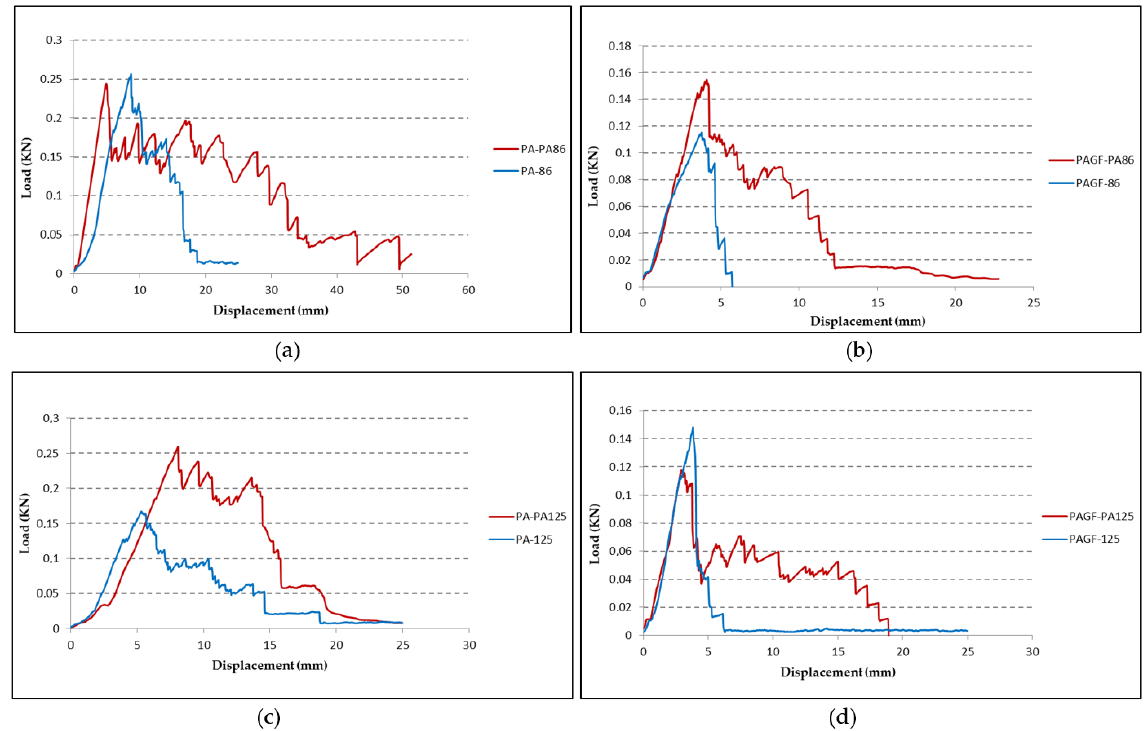
Figure 10. Comparison of peeling test results between conventional fiberglass fabrics and hybrid fabrics. ( a ) PA matrix + GF86, composites 7, 3. ( b ) PAGF matrix + GF86, composites 11, 5. ( c ) PA matrix + GF125, composites 8, 4. ( d ) PAGF matrix + GF125, composites 12, 6.